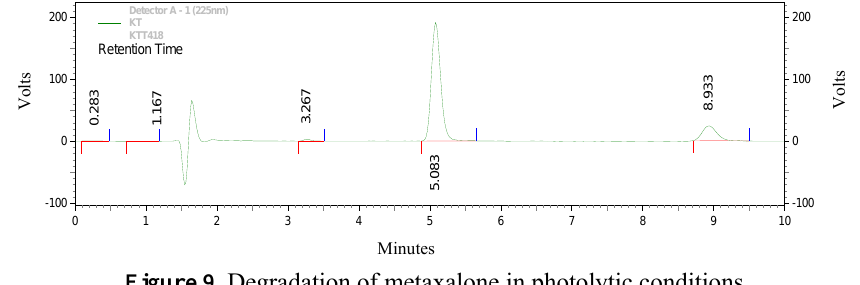
Figure 9. Degradation of metaxalone in photolytic conditions (Retention time of metaxalone is 5.083 min and IS (Gliclazide) is 8.933